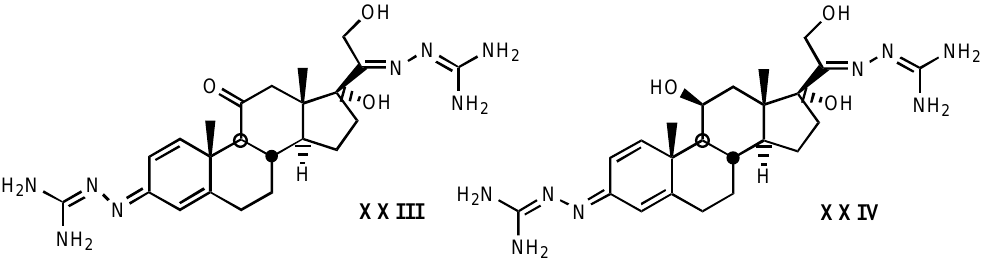
Figure 23. Structure of 3,20-guanylhydrazones of prednisone ( XXIII ) and prednisolone ( XXIV ). It was later observed that PGB differs from ouabain in not showing high and low affinity for differ- ent Na+ ,K+ -ATPase isoenzymes, although it showed large differences related to potency if different species are considered, and it also inhibited 3 H-ouabain binding [107]. This can be interpreted as either PGB binds to the digitalis receptor, but some parts of the enzyme not affecting to isoenzyme differen- tiation are involved, or it binds to a different site from digitalis receptor and then induces conforma- tional changes inhibiting ouabain